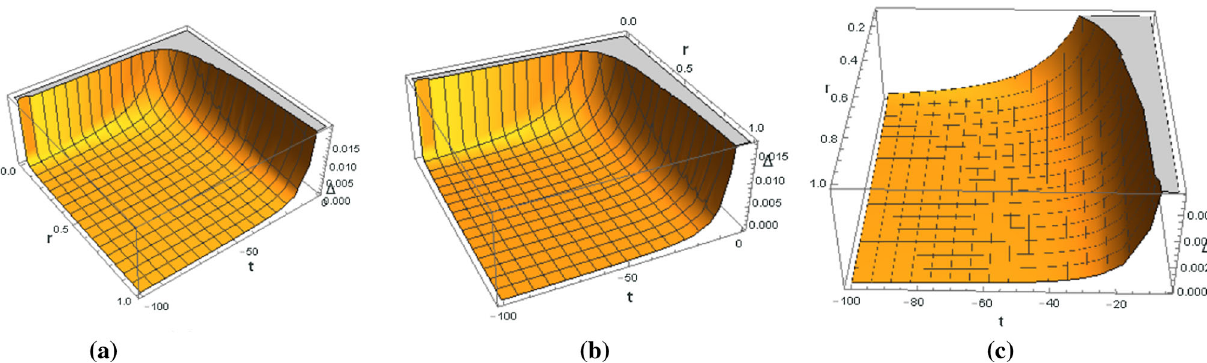
Fig. 4 a – c Shows the plots of the pressure anisotropy (cid:6) (36) w.r.t. time t and radial r coordinates for f ( R ) = R + λ R 2 with λ = 5, f ( R ) = R 1 + (cid:3) with (cid:3) = 0 . 01 and f ( R ) = R + λ